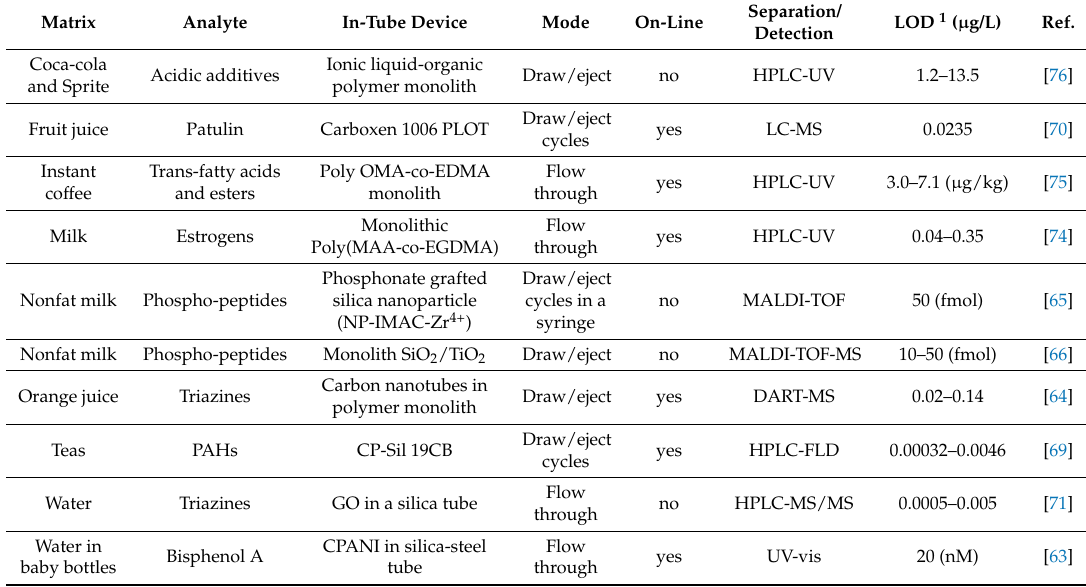
Table 3. Beverages applications summary of in-tube SPME in the last